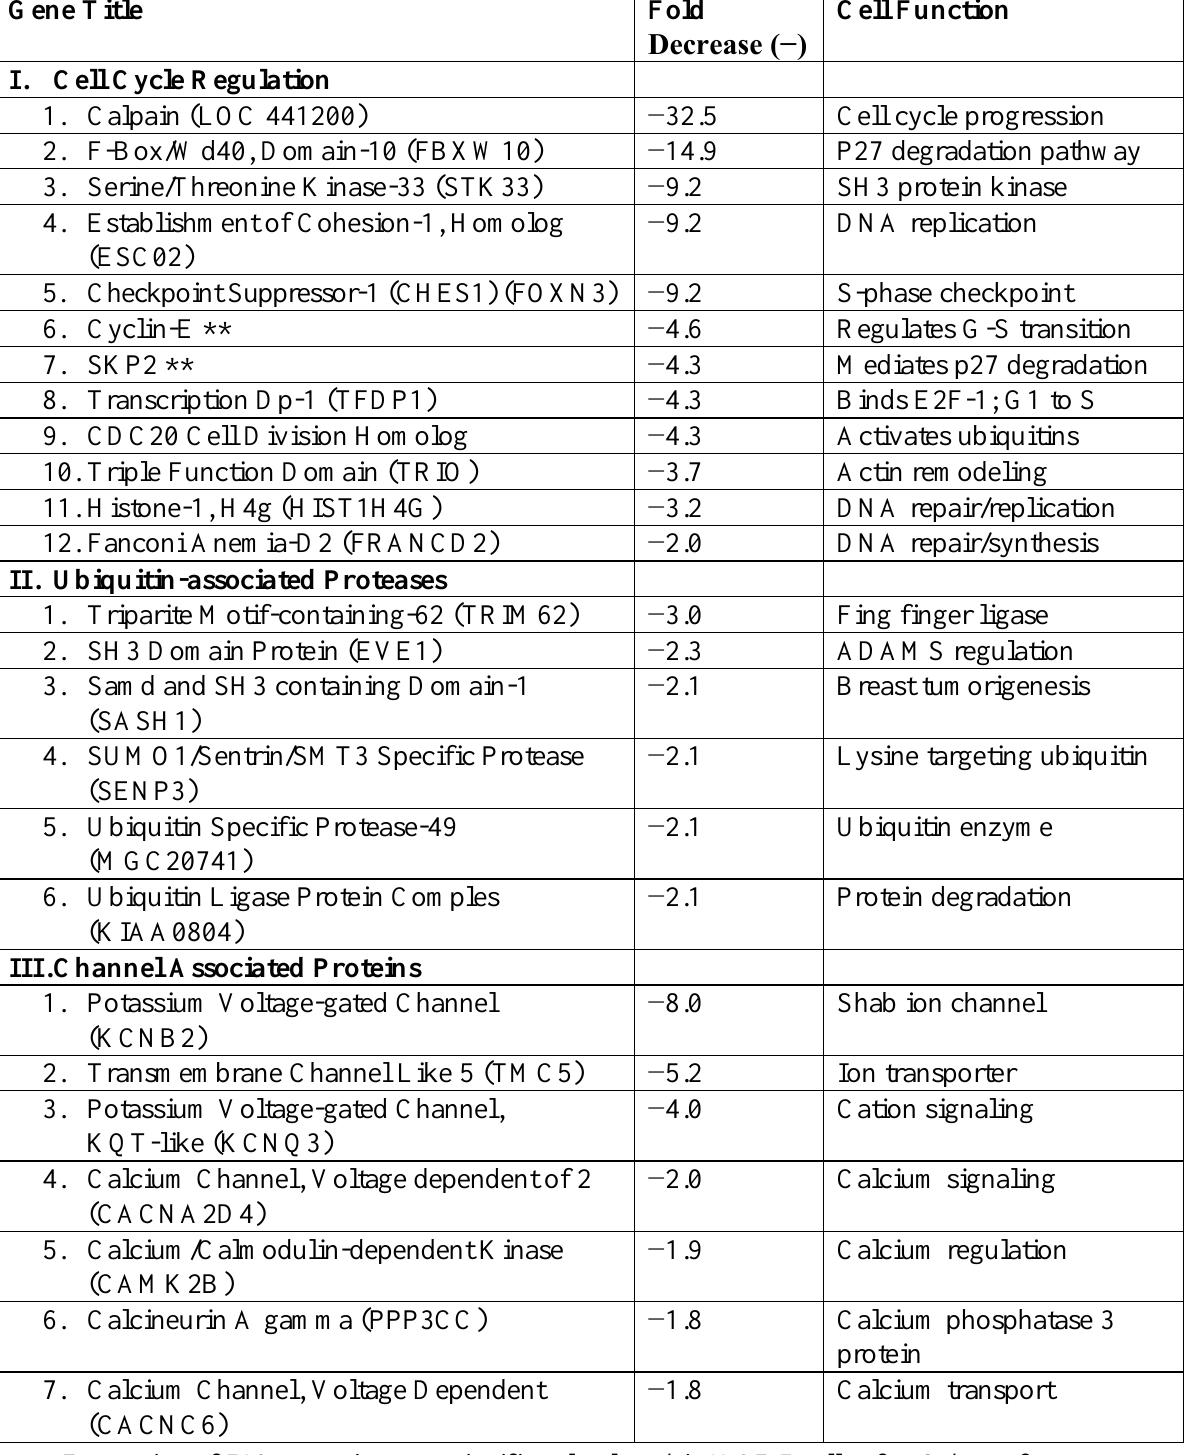
Table 2. Global RNA microarray data: Transcripts displaying 1.0 or larger log fold (log base 2.0) decrease for genes associated with cell division and proliferation processes, ubiquitization, and cation channels obtained from Human MCF-7 breast cancer cells in vitro